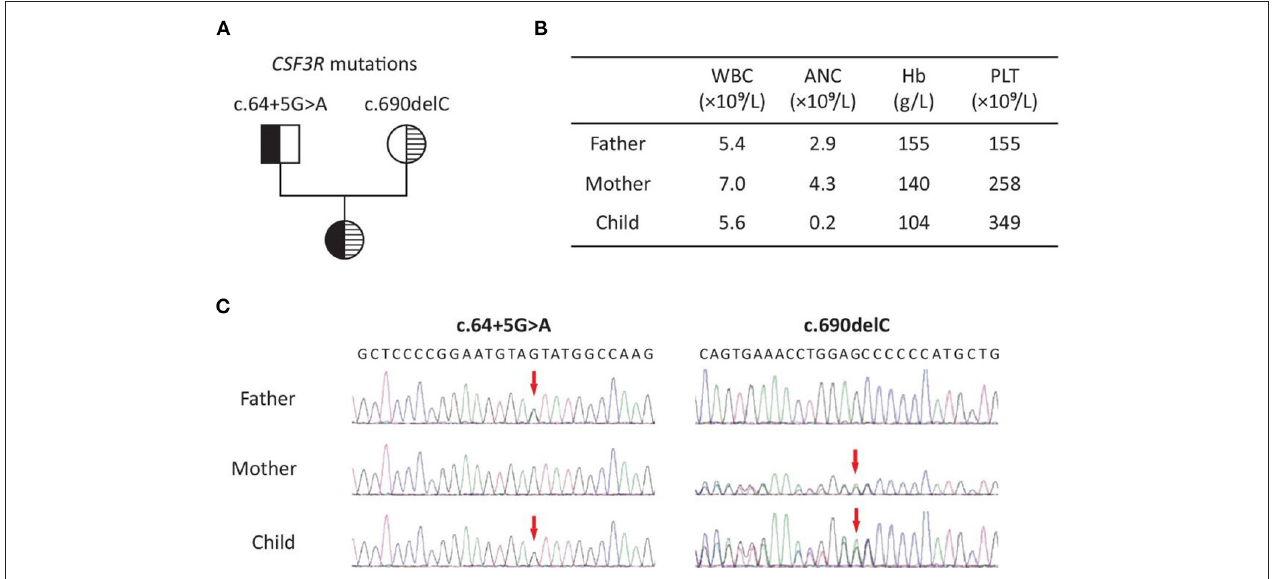
FIGURE 1 | Patient with SCN7 due to biallelic CSF3R mutations: (A) pedigree; (B) representative results of complete blood count in the family; (C) Sanger sequencing chromatogram of c.64 + 5G > A and c.690delC (NM_000760.3). WBC, white blood cell; ANC, absolute neutrophil count; Hb, hemoglobin; PLT, platelet.